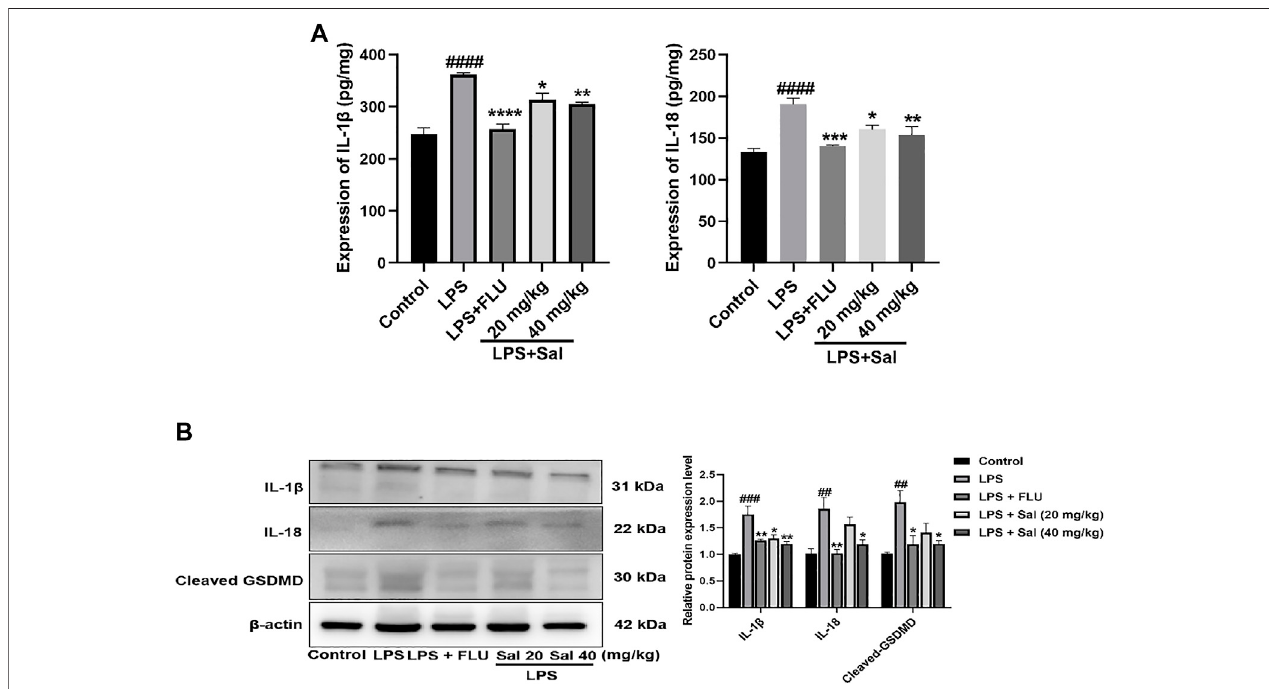
FIGURE 5 | Sal relieves pyroptosis in LPS-induced depression in mice. (A) The expression of IL-1 β and IL-18 in the hippocampus was measured by ELISA assay ( n = 5). (B) The concentrations of cleaved GSDMD, IL-1 β and IL-18 proteins in the hippocampus were analyzed by Western blot ( n = 3). #### p < 0.0001, ### p < 0.001, ## p < 0.01 compared with the normal group; *** p < 0.001, ** p < 0.01, * p < 0.05 compared with the LPS